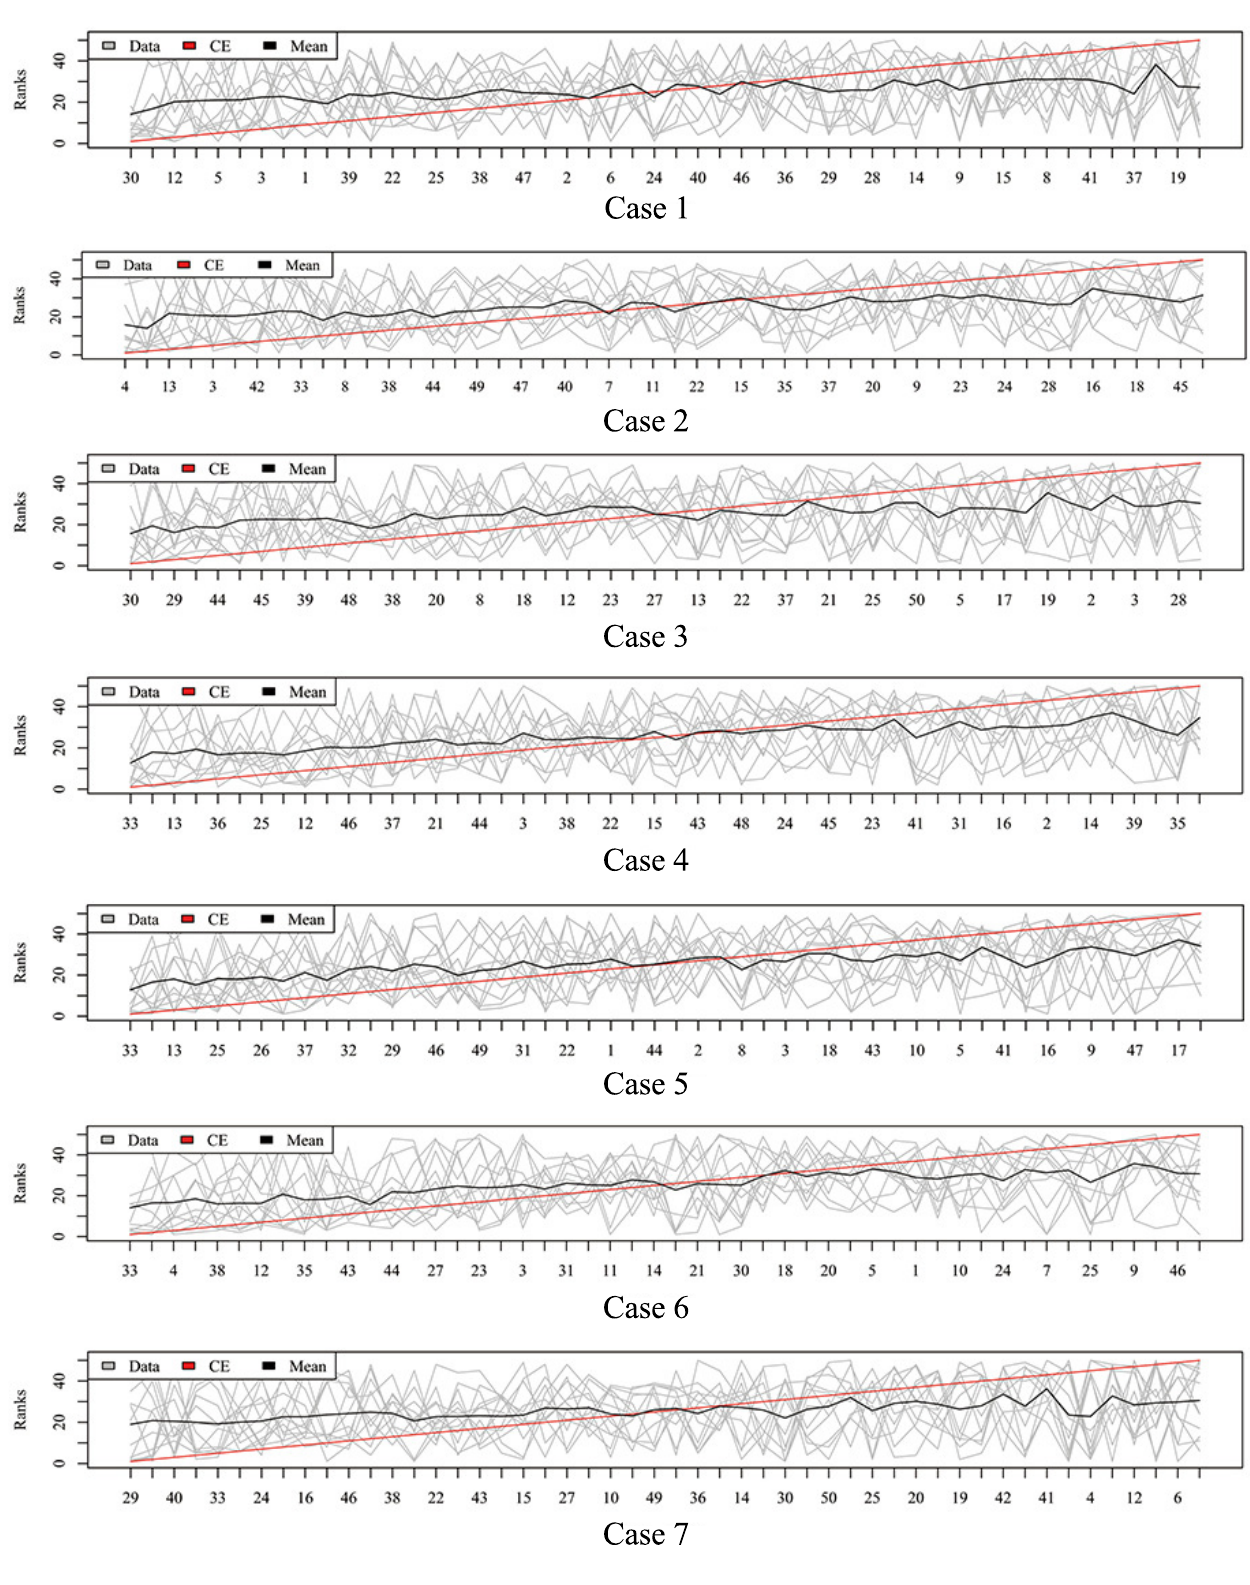
Figure 5. Rank lists of rank aggregation with the dataset “CHD2-2” on seven